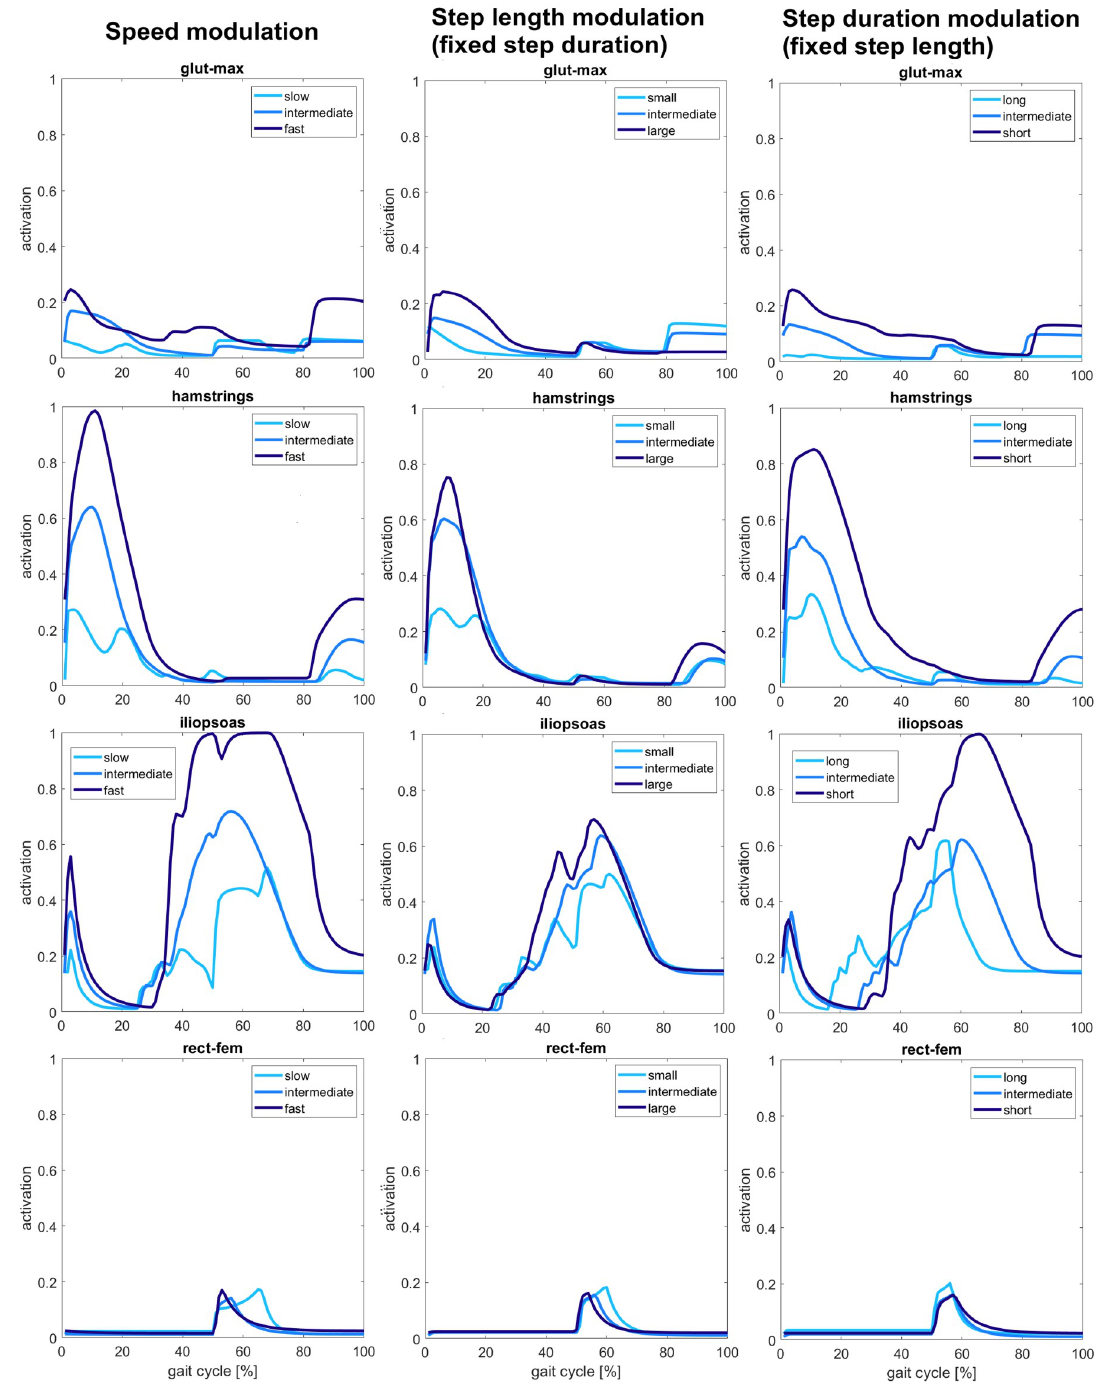
Fig 8. Hip muscles activity. Hamstrings and iliopsoas activity show a significant increase with increasing speed and step duration. Gluteus maximus activation is less evident, but it increases activation at the fastest speeds, whereas the rectus femoris does not show significant